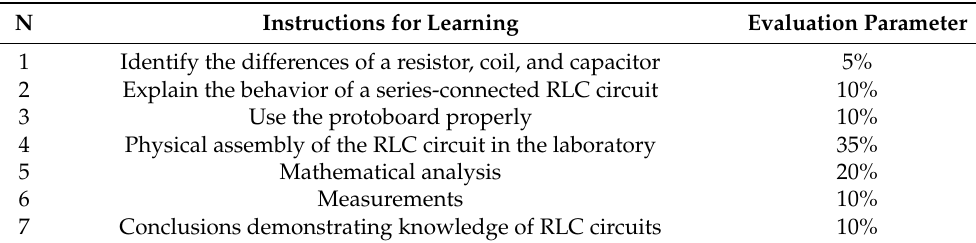
Table 7. Evaluation rubric for RLC analysis.